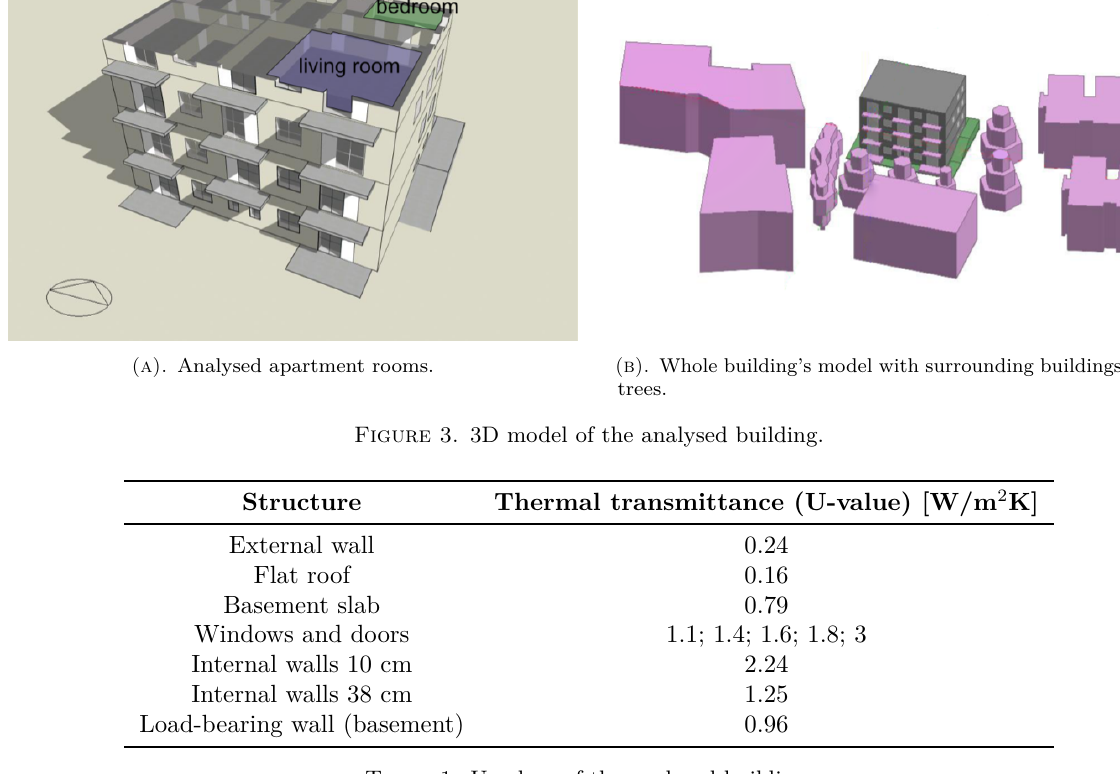
Table 1. U-values of the analysed